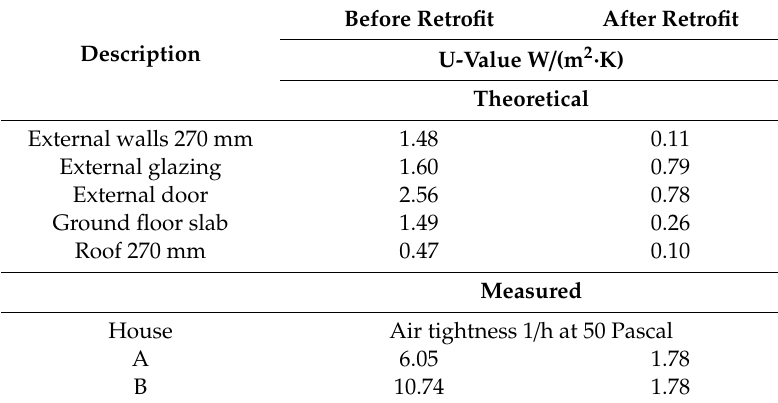
Table 6. Envelope characteristics before and after the retrofit (source [19]).